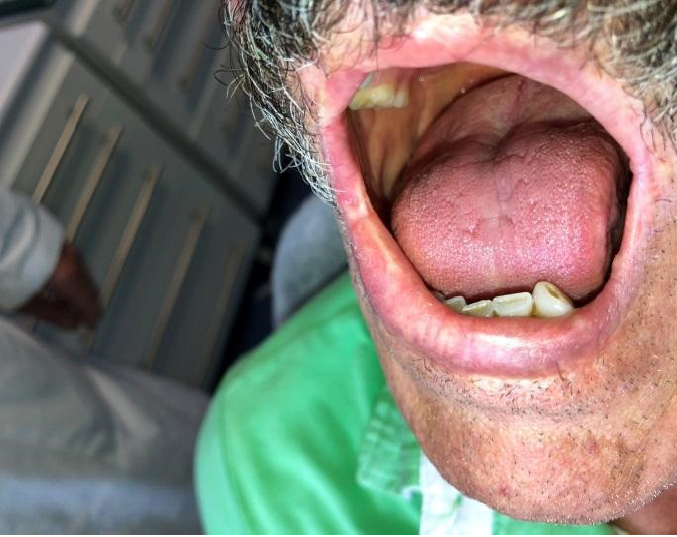
Figure 10. Case 2: Follow up at six months. Dynamic position, lateral view.